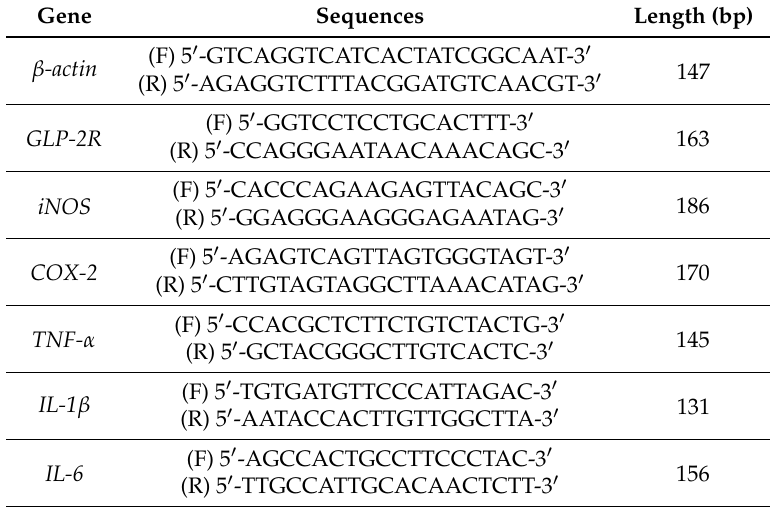
Table 1. The primer sequences of β -actin, GLP-2R, iNOS, COX-2, TNF- α , IL-1 β , and